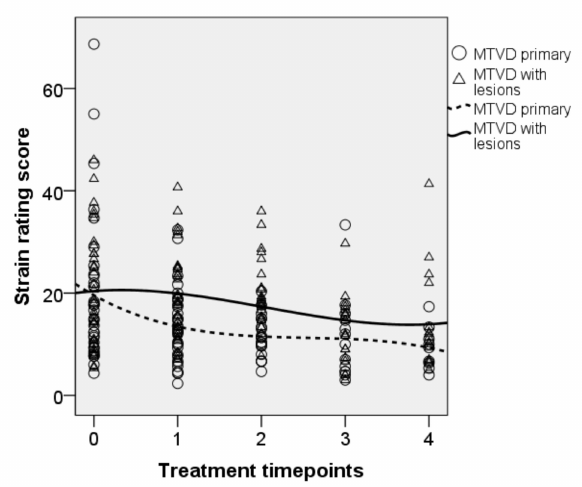
Figure 5. Longitudinal plot of data for the strain ratings. Trend line is shown for each subgroup. 0 = baseline, 1 = OPT, 2 = SVQ, 3 = SVQ variant, and 4 = NP.